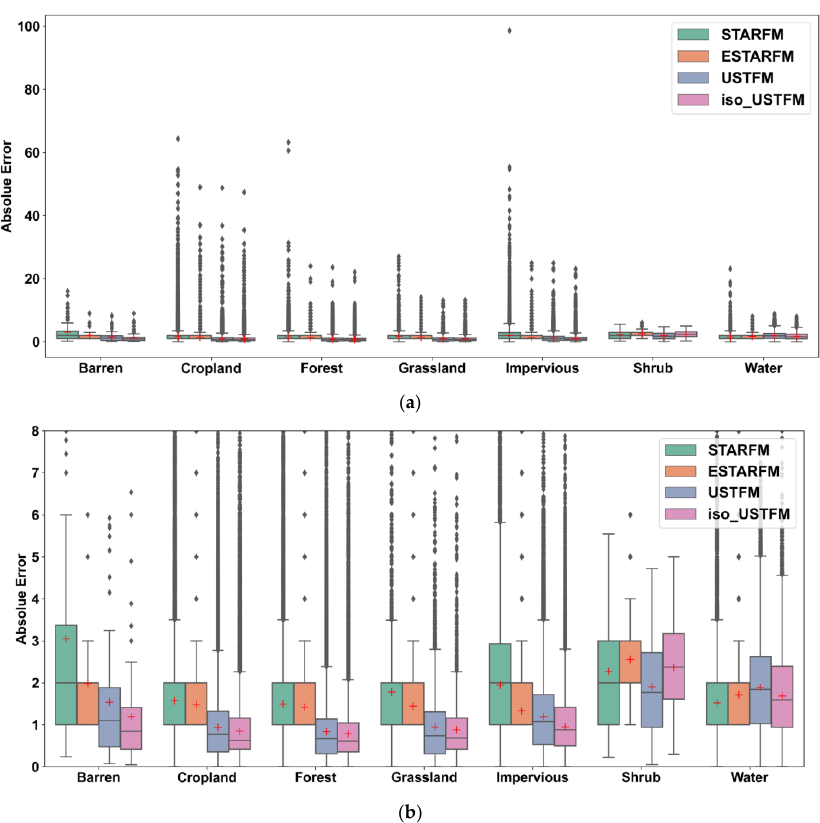
Figure 11. ( a ) Comparison of absolute error distribution of model fusion results for land cover categories in 2001. ( b ) 0–8 k range of ( a ).